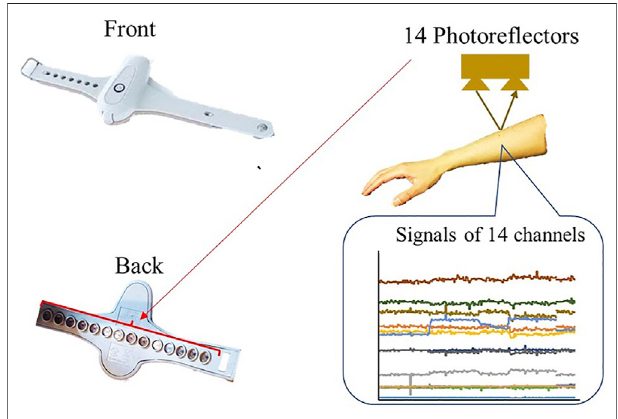
FIGURE 1 | Infrared optical sensor